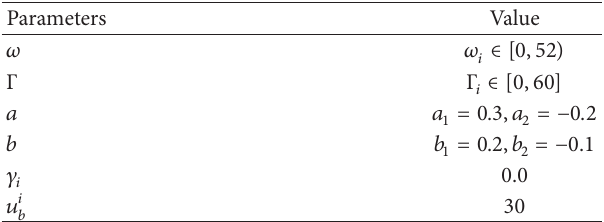
Table 2: CPG parameter values applied to the robotic